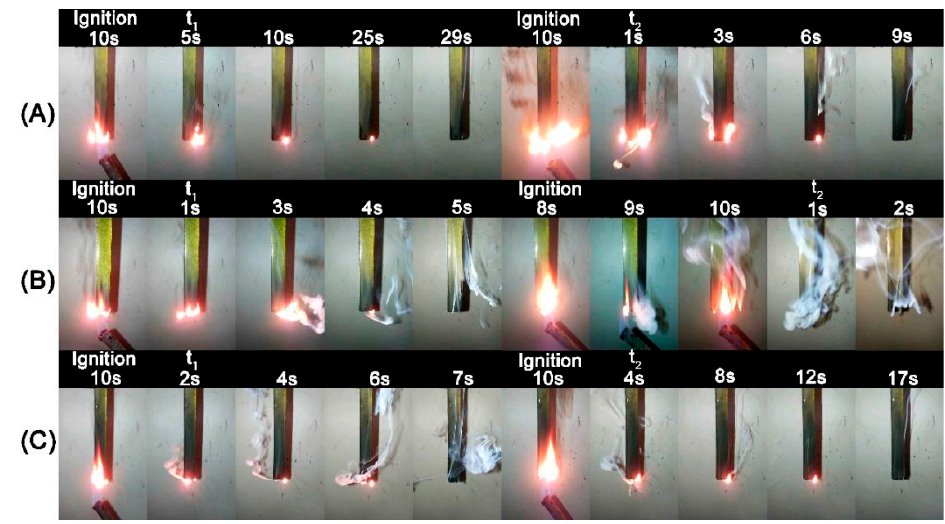
Figure 1. Video screenshots of a vertical burning test of 1%HPDAl/EP ( A ); 2%HPDAl/EP ( B ); and 3%HPDAl/EP ( C ).